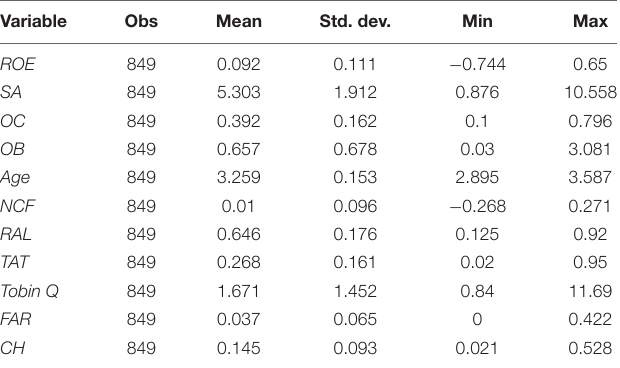
TABLE 2 | Descriptive statistical results of the whole sample.